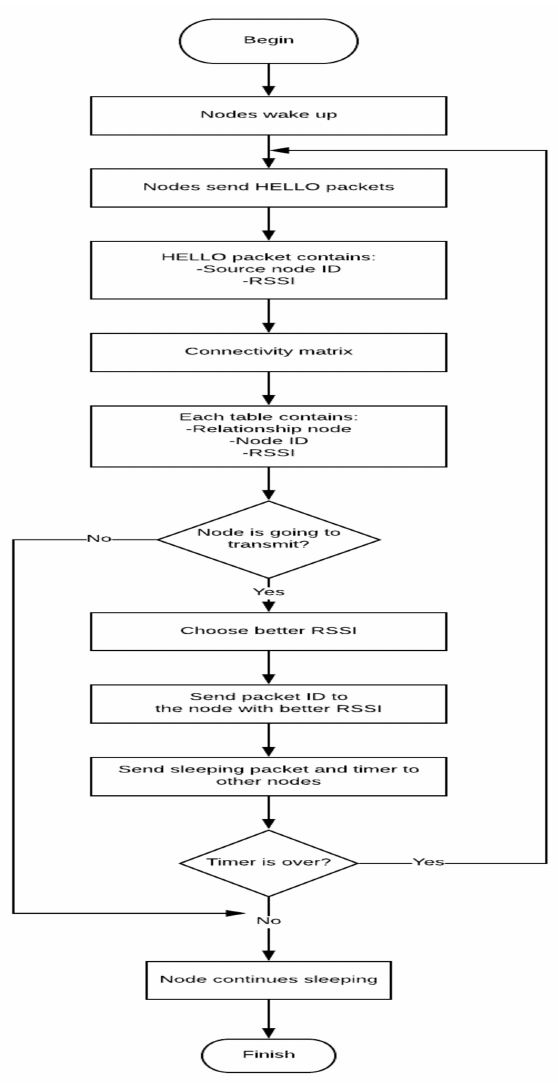
Figure 4. Sleeping algorithm proposed by the authors named Timer sleeping algorithm